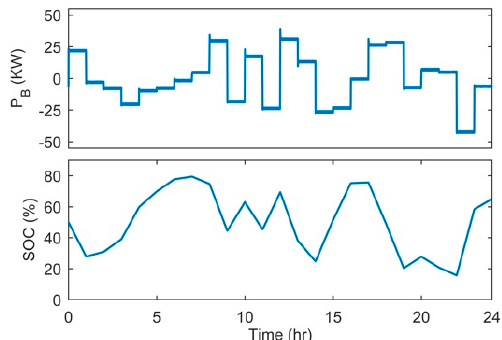
Figure 11. Performance of the BES system. Energies 2019 , 12 , x FOR PEER REVIEW